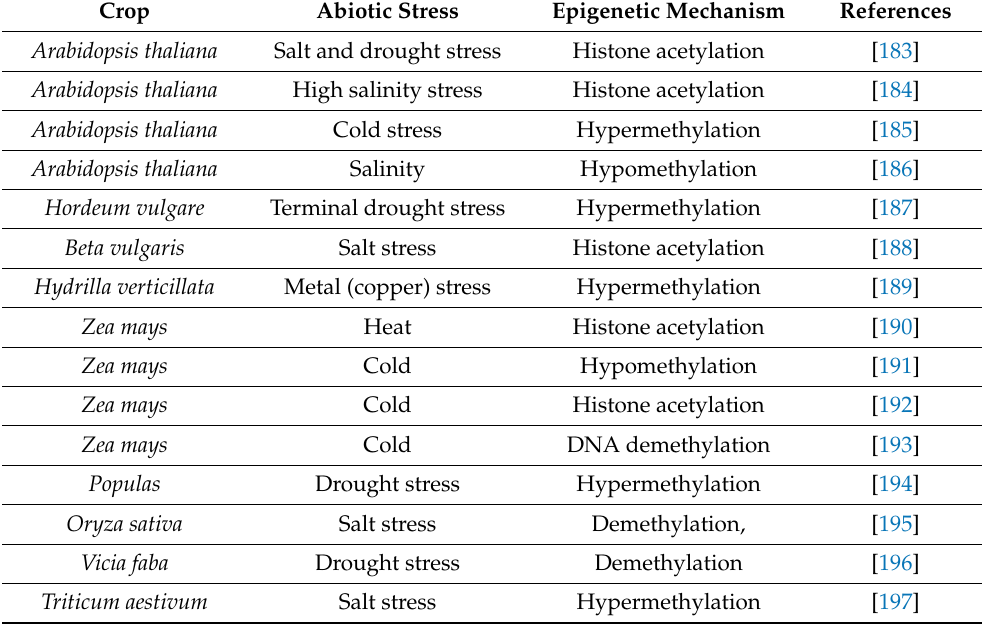
Table 3. Epigenetic mechanisms induced in different crop species under abiotic